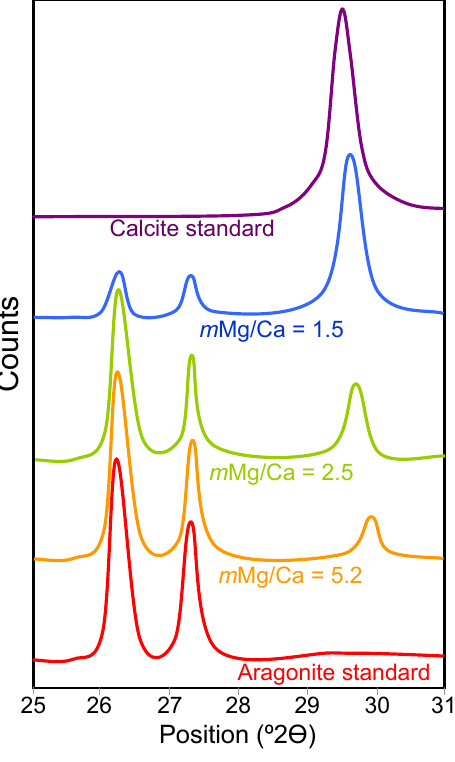
Fig. 3. Purple curve: X-ray diffraction pattern for pure calcite, re- vealing primary calcite peak [d(104); 3.03–3.04 ˚A; 2 θ =29.4–29.5 ◦ ]. Blue curve: X-ray diffraction pattern for a H. incrassata alga that produced 54% aragonite and 46% calcite when reared in the ex- perimental calcite seawater (Mg/Ca=1.5; [Ca 2 + ]=25.3mmolkg- SW − 1 ) . Green curve: X-ray diffraction pattern for a H. incrassata alga that produced 84% aragonite and 16% calcite when reared in the boundary aragonite-calcite experimental seawater (Mg/Ca=2.5; [Ca 2 + ]=18.1mmolkg-SW − 1 ) . Orange curve: X-ray diffraction pattern for a Halimeda incrassata alga that produced 92% arag- onite and 8% calcite when reared in experimental seawater that favors the nucleation of the aragonite polymorph (Mg/Ca=5.2; [Ca 2 + ]=10.2mmolkg-SW − 1 ) . Red curve: X-ray diffraction pat- tern for pure aragonite, revealing primary aragonite peak [d(111)] at 2 θ =26.2 ◦ (3.40 ˚A) (data from Ries, 2005a, b, 2006a; Stanley et al.,